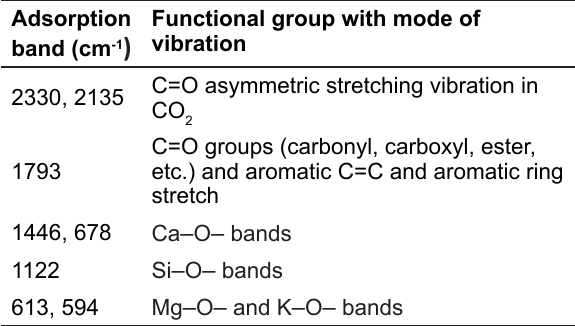
Fig. 2. The FTIR spectra of pine wood ash Table 3. Functional groups and the modes of vibrations of various